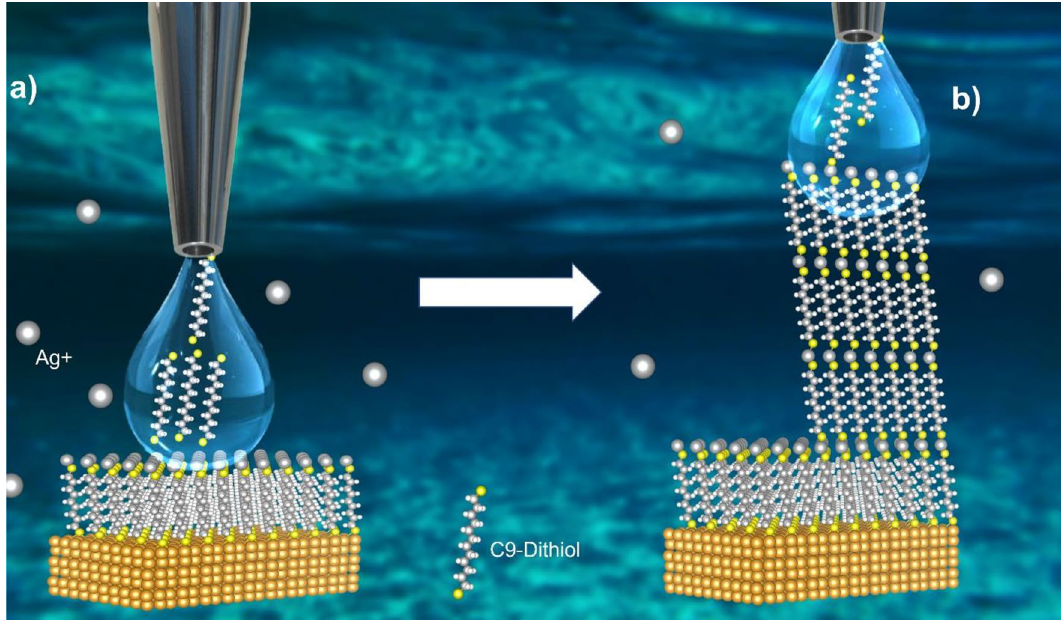
Figure 1. Principle of molecular self-assembly based 3D printing. Schematics of continuous self-assembly of C9-dithiol molecules at water-hexane interface mediated by silver atoms. ( a ) Solution containing dithiol molecules injected through a contact angle nozzle on top of the metal-SAM interface. ( b ) Injection of the dithiol molecule solution and pulling up the nozzle at the same time enable to create a periodic and continuous metals- SAMs multilayer